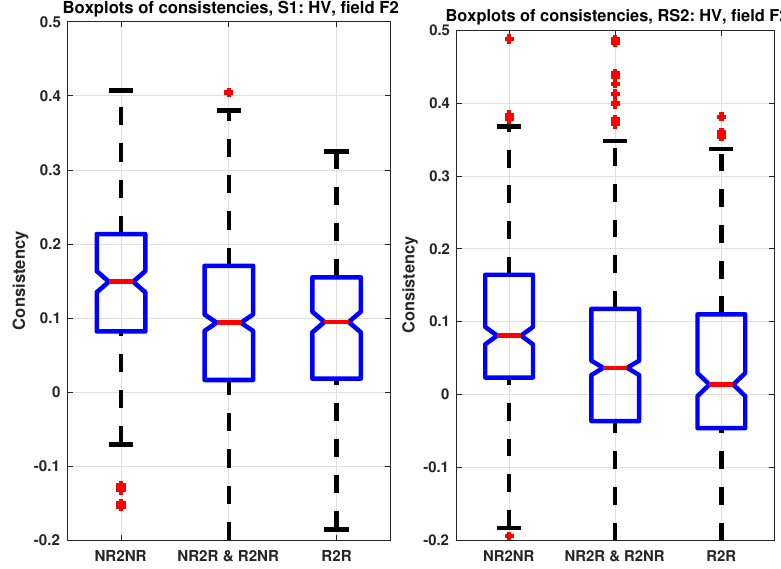
Figure 16. Box plots of all consistencies for S1 HV ( left ) and RS2 HV ( right ) per rain-condition pair, representing no rain to no rain (NR2NR), no rain to rain and rain to no rain combined (NR2R and R2NR), and rain to rain (R2R). Central (red) line indicates the median, and bottom and top box edges represent the 25th and 75th percentiles, respectively. Whiskers span to the most extreme data points not considered outliers and cover approximately 99% of the values. Notches represent the 95% confidence intervals of the